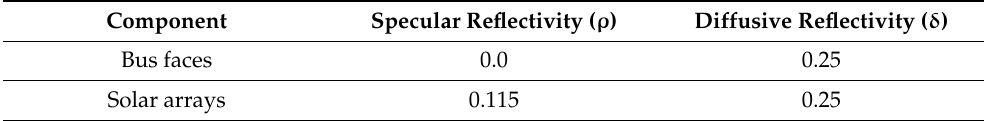
Figure 9. ArgoMoon simplified shape model. Table 6. ArgoMoon thermo-optic coefficients.